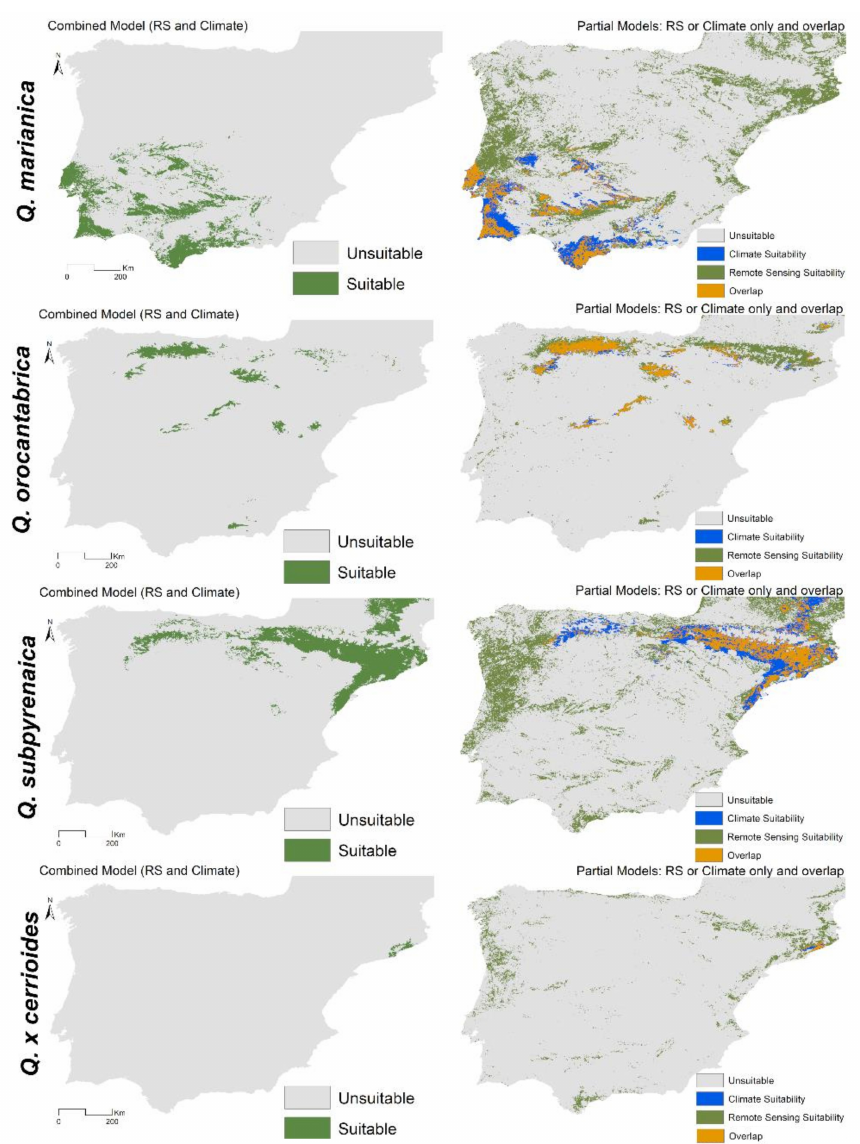
Figure 6. (Left) Combined models (remote sensing (RS) EFA and climate) and partial models (remote sensing EFA in green or climate in blue and their spatial overlap in orange colour) (right) for narrow endemic oaks ( Q. marianica, Q. orocantabrica, Q. subpyrenaica, Q. × cerrioides